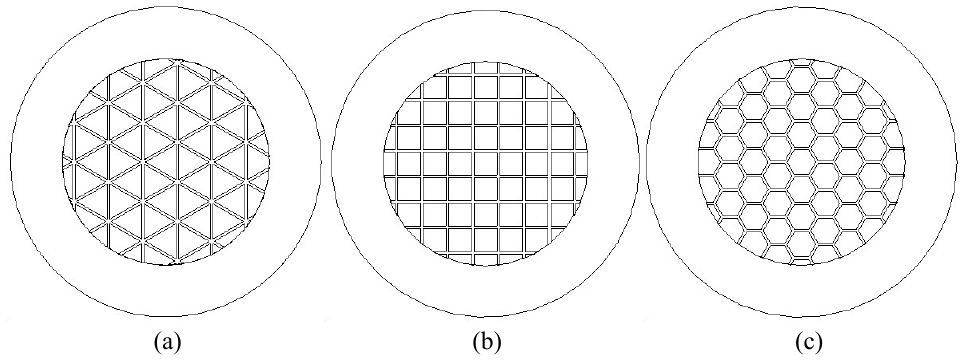
Figure 4. Common grid aperture shapes. ( a ) Triangle. ( b ) Quadrilateral. ( c )